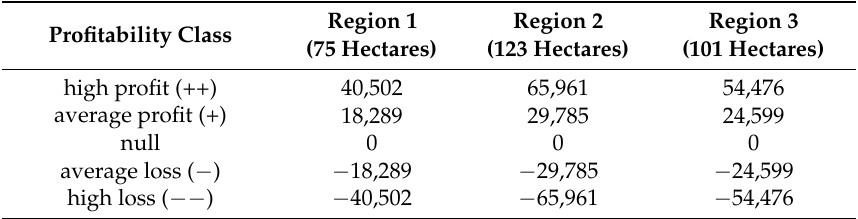
Table A1. Profitability (in GBP) of each region in the catchment around